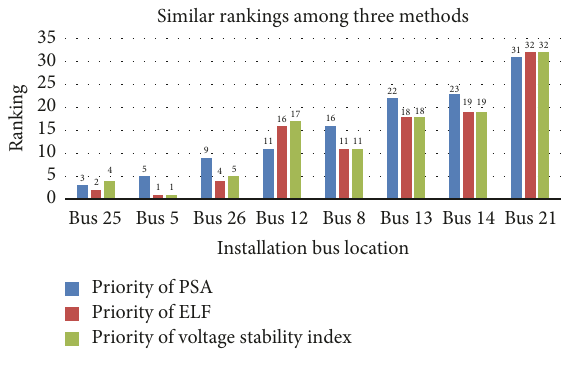
Figure 7: Similar rankings among three